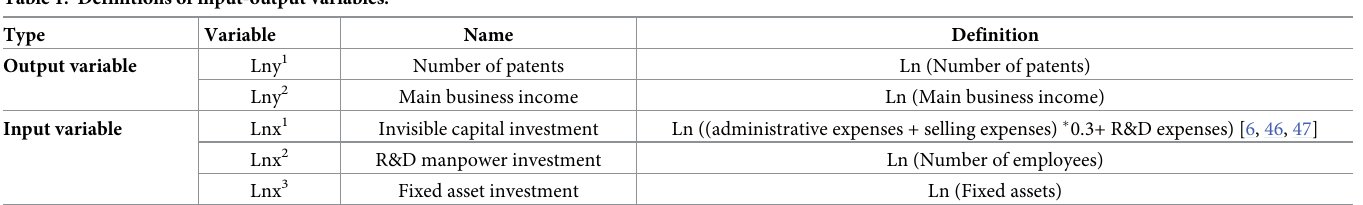
Table 1. Definitions of input-output variables.